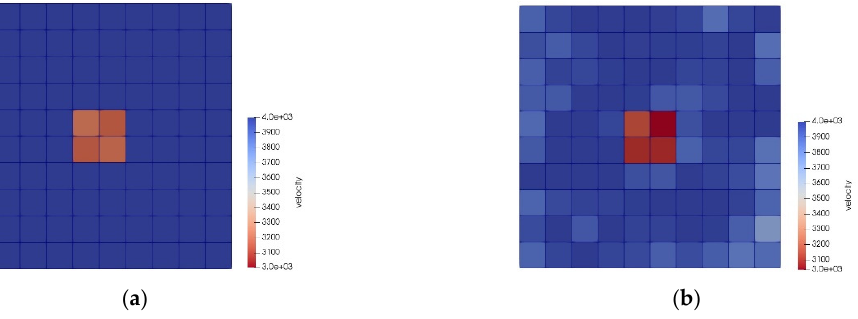
Figure 12. Identified results of case 2: ( a ) LASSO algorithm; ( b ) SIRT algorithm.